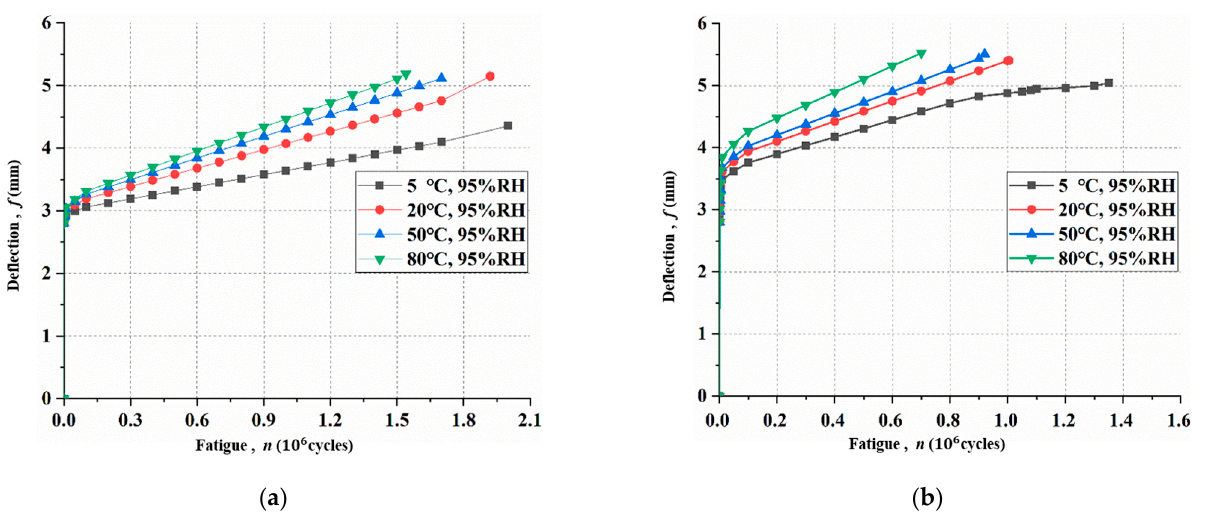
Figure 5. Maximum deflections under different fatigue loads and hygrothermal environments: ( a ) 27.5 kN; ( b ) 30.0 kN.